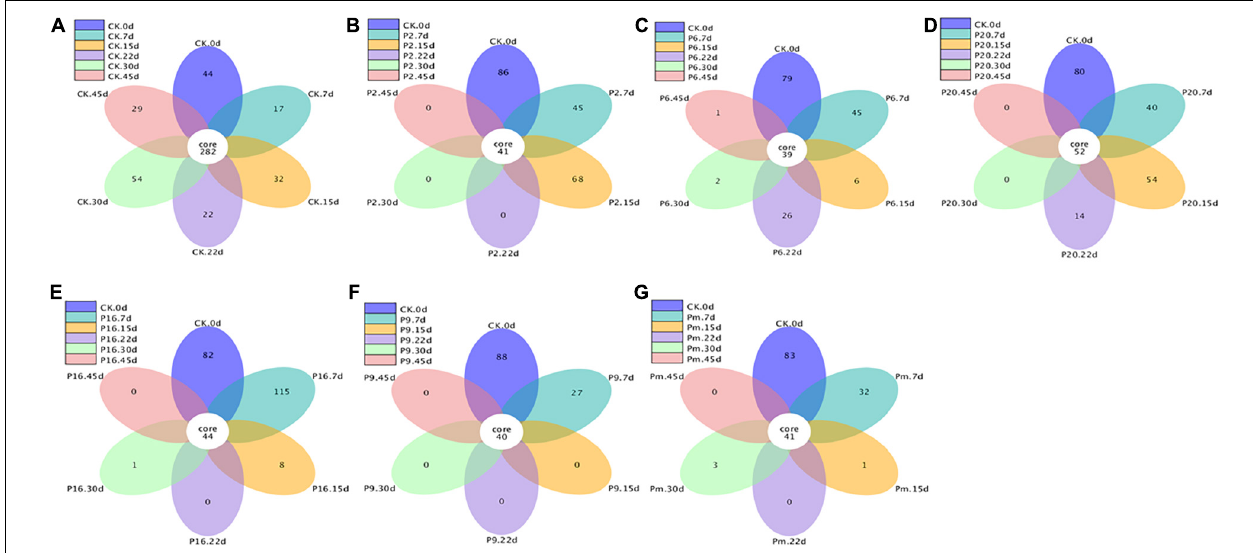
FIGURE 5 | Flower figure showing the unique and shared OTUs of the bacterial communities across different stages. Only with more than five groups can the flower figure be shown. The plotting was carried out after homogenization of all samples. CK, Control; P2, Staphylococcus xylosus ; P6, Leuconostoc mesenteroides ; P9, Carnobacterium maltaromaticum ; P16, Leuconostoc gelidum ; P20, Serratia liquefaciens ; Pm, The five strains in combination.